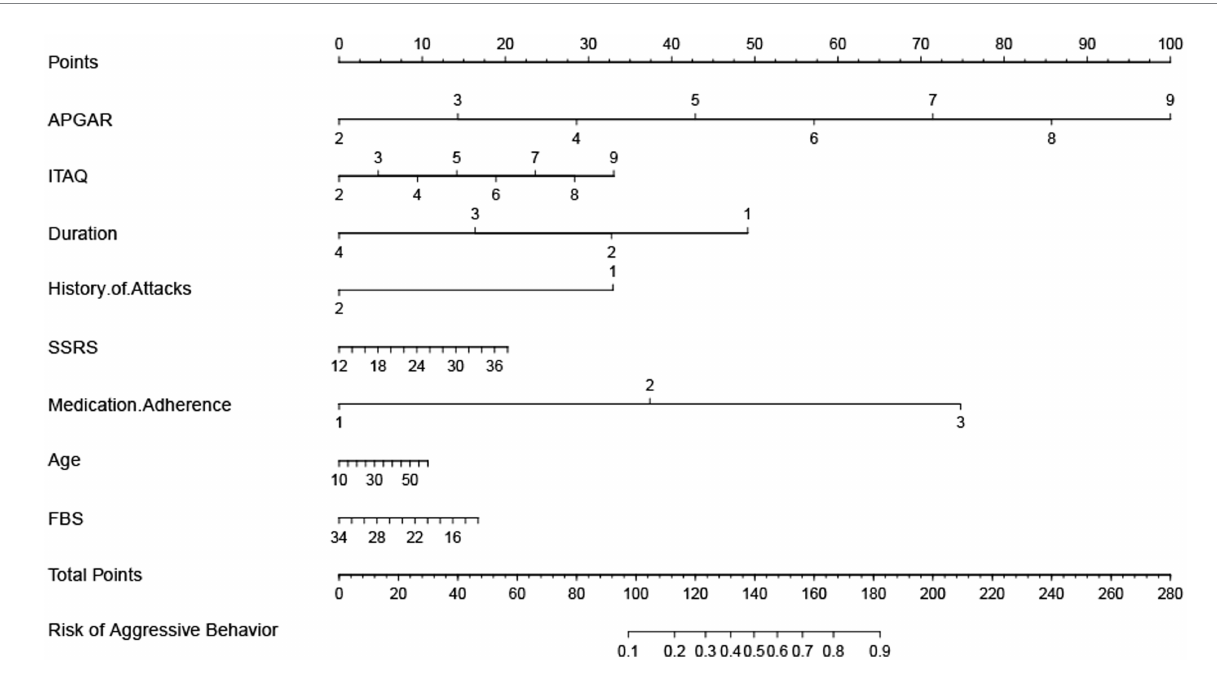
FIGURE 5 Nomogram based on the top 8 significant features (variables) filtered by Random Forest.